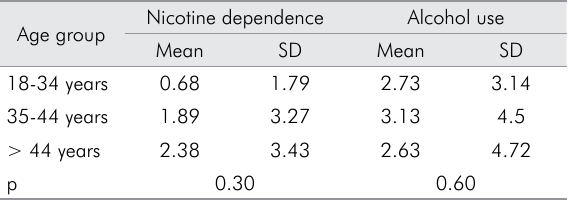
Table 3. Mean nicotine dependence and alcohol use scores (SD) according to age